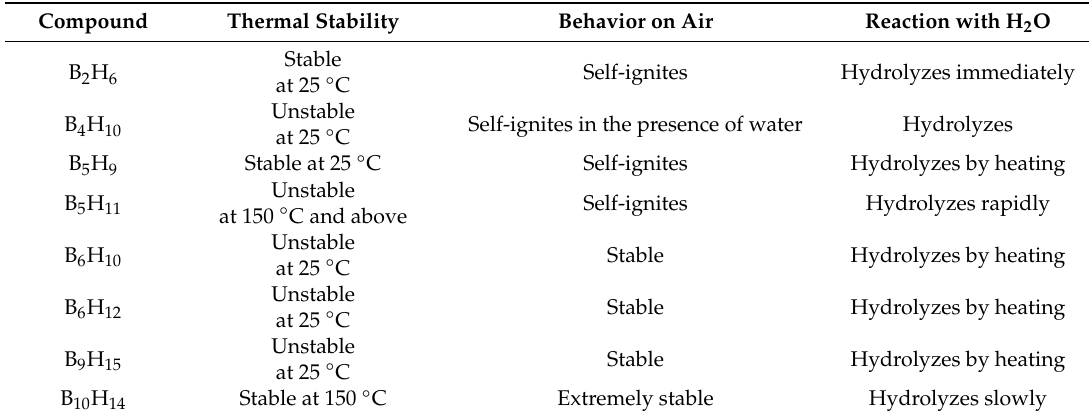
Table 2. Some characteristics of the most important boranes